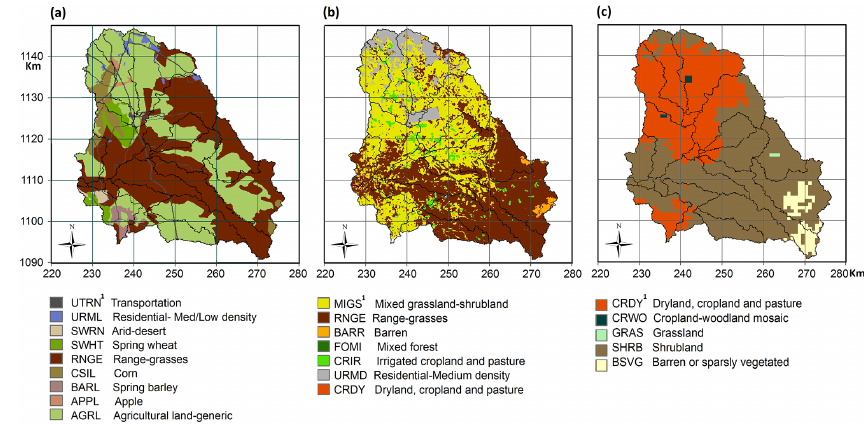
Figure 3. Land-use classification over the Wala catchment: (a) Tarawneh (2007); (b) Al-Bakri et al. (2013); (c) WaterBase (2013). 1 SWAT land-use codes (Arnold et al., 2013).